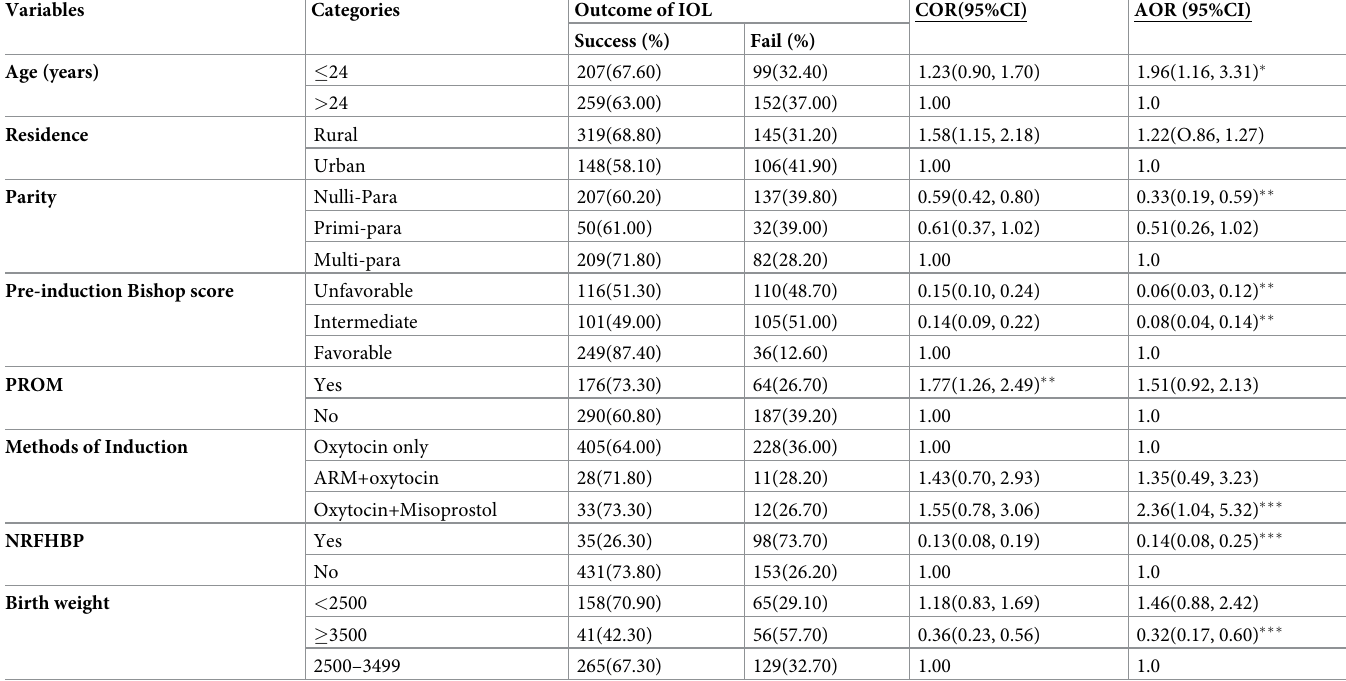
Table 4. Multivariable logistic regression analysis of factors associated with the success of induction of labor among mothers who delivered after induction of labor in public Hospitals of Harari Regional State, Eastern Ethiopia, 2019.